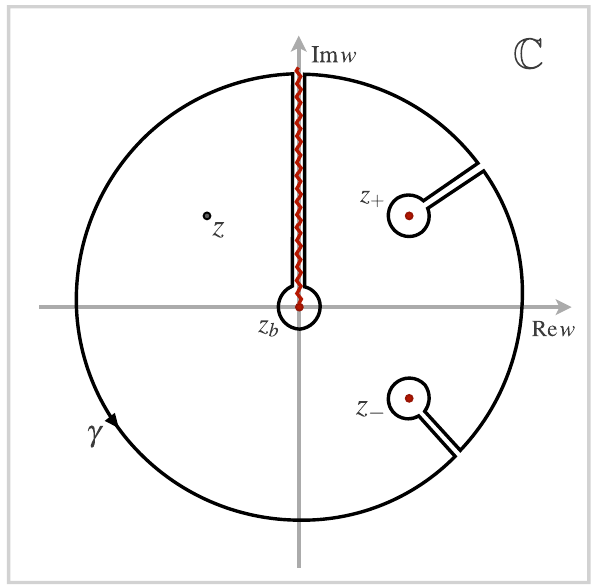
FIG. 5. Cauchy’s theorem and branch-cut structure: we use (cid:31) Cauchy’s theorem f ( z ) = ( 1 / 2 π i ) dw [ f ( w )/( w − z ) ] for the γ multiple keyhole contour γ , which avoids the isolated poles and the branch cut such that the function is analytic inside. The sim- ple poles lie at z ± = π ± i /ξ eff , where the effective Compton wavelength is given in Eq. (95). This describes the broadening and screening of the zigzag mode k s a = π . The residues of the , where the effective speed of light poles are r = r ∗ = πξ eff a / c 2 t is given by Eq. (80). The branch point at ee iz b = 1 is connected to the point at infinity by a branch cut along the positive imagi- nary axis, displaying a discontinuity that is calculated using the properties of the polylogarithms, leading to Eq.